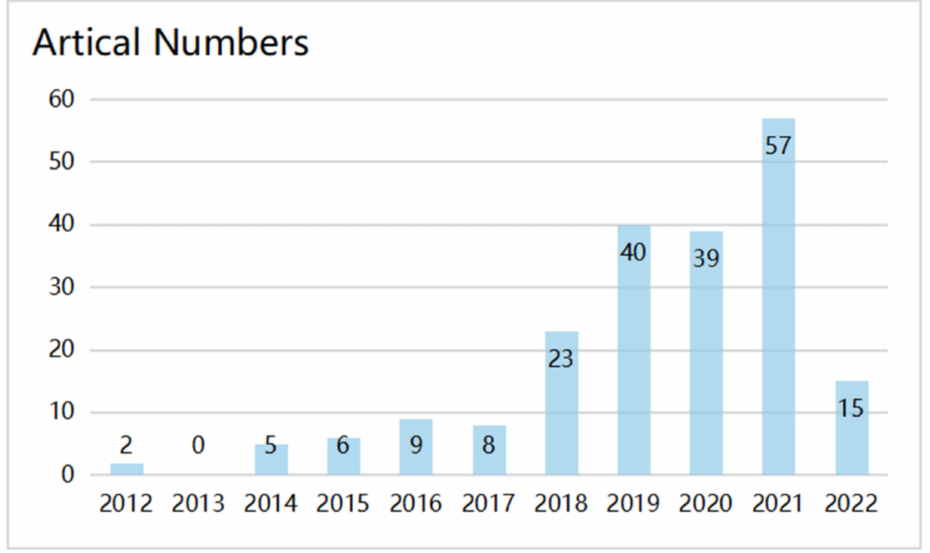
Figure 7. Annual distribution of the bibliographic